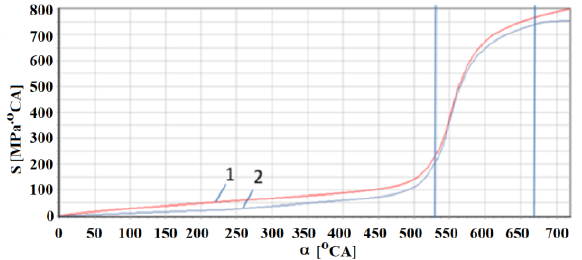
Fig. 6. Integral curves of the medium pressure: 1 – obtained from the model, 2 – measured as the function of the crankshaft revolution angle